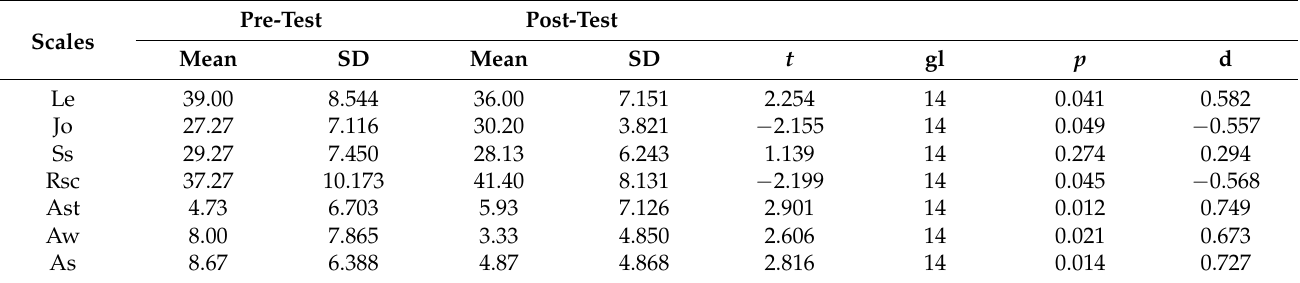
Table 6. Scores obtained in the parents’ BAS at the beginning and end of the third grade of primary